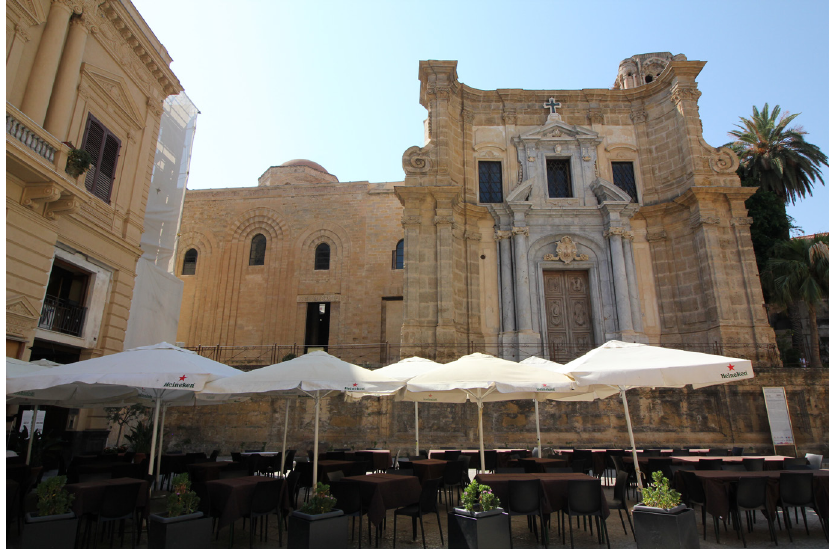
Figure 2: Palermo, piazza Bellini, church of St. Mary of the Admiral, northern facade (photo V.